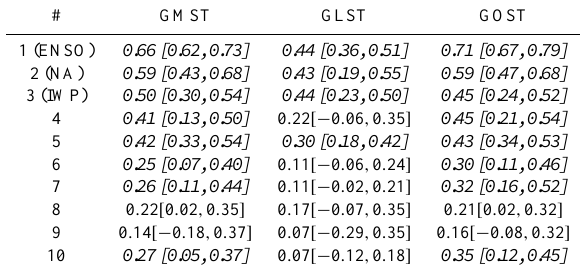
Table 1. Correlations between the mean time series of the commu- nities of the H-SST network and the indices of mean, land and ocean surface temperatures (all time series 1y low-pass filtered). The 95% confidence intervals are given in brackets and correlations signifi- cant at 5% in italic face.